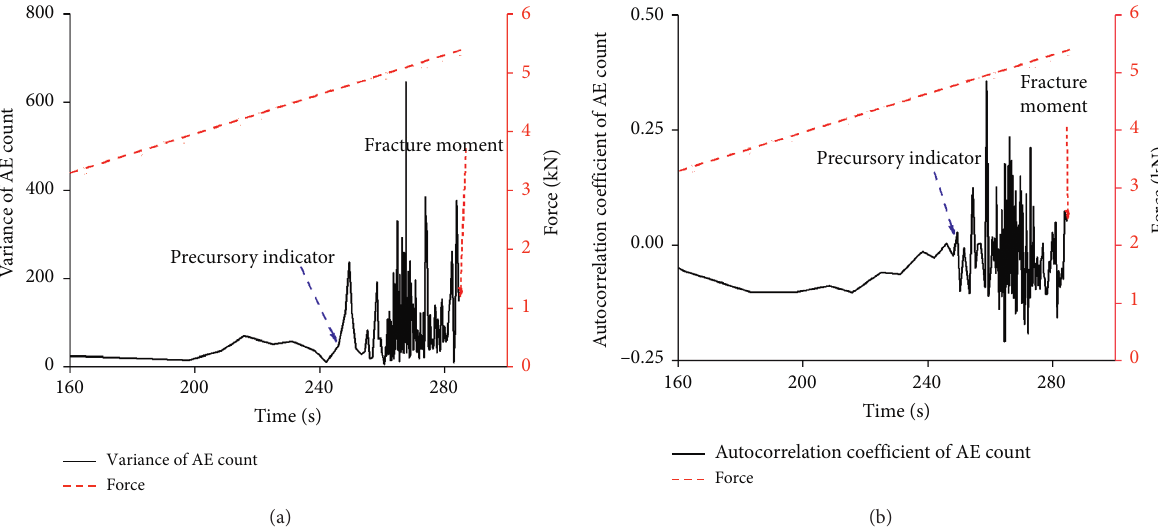
Figure 9: Variance and autocorrelation coefficient curves of AE counts with the loading time: (a) variance; (b) autocorrelation coefficient.